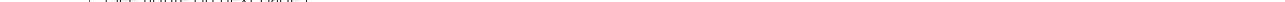
figure on next Fig. 2 Proposed algorithm for fluid resuscitation in severe acute pancreatitis. Hypovolemic shock is reversed with intravenous balanced crystalloids until Resuscitation goals are met. In the Optimization phase, a continuous infusion should be provided to meet ongoing fluid losses. A continuous Reassessment is required to assess further needs for fluids, guided by advanced hemodynamic monitoring systems, aiming to define the real fluid requirements while evaluating any signs of fluid overload. The Stabilization evolves over the following days. Here, fluids are needed only to replenish ongoing losses and the evacuation starts with spontaneous or induced evacuation when the acute insult resolves. IV Intravenous; MAP Mean arterial pressure; UO Urinary output; Ht Hematocrit; BUN Blood urea nitrogen; IAP Intra-abdominal pressure; CVP Central venous pressure; GIPS Global